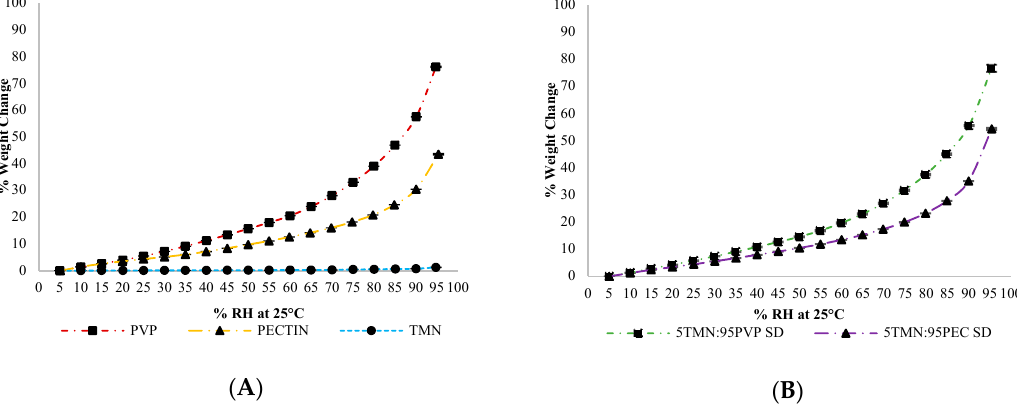
Figure 5. Moisture sorption profiles of ( A ) pure PVP, PEC, and TMN; and ( B ) solid dispersions of 5TMN:95PVP and 5TMN:95PEC following lyophilization at 25 °C. Thiamine degradation was also monitored in amorphous solid dispersions: in 5TMN:95PEC and 5TMN:95PVP solid dispersions at 11% RH and four di ff erent temperatures (30, 40, 50 and 60